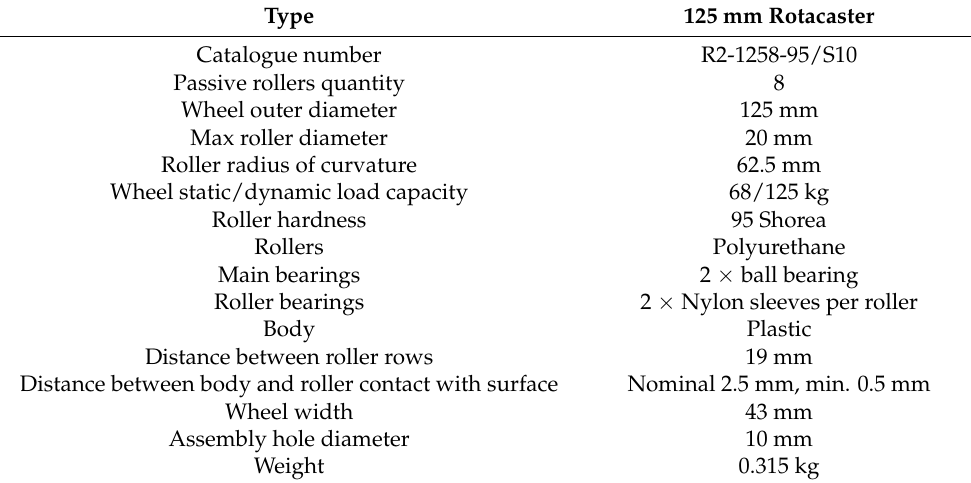
Table 2. Technical specification of the Rotacaster 125 mm omnidirectional wheel.